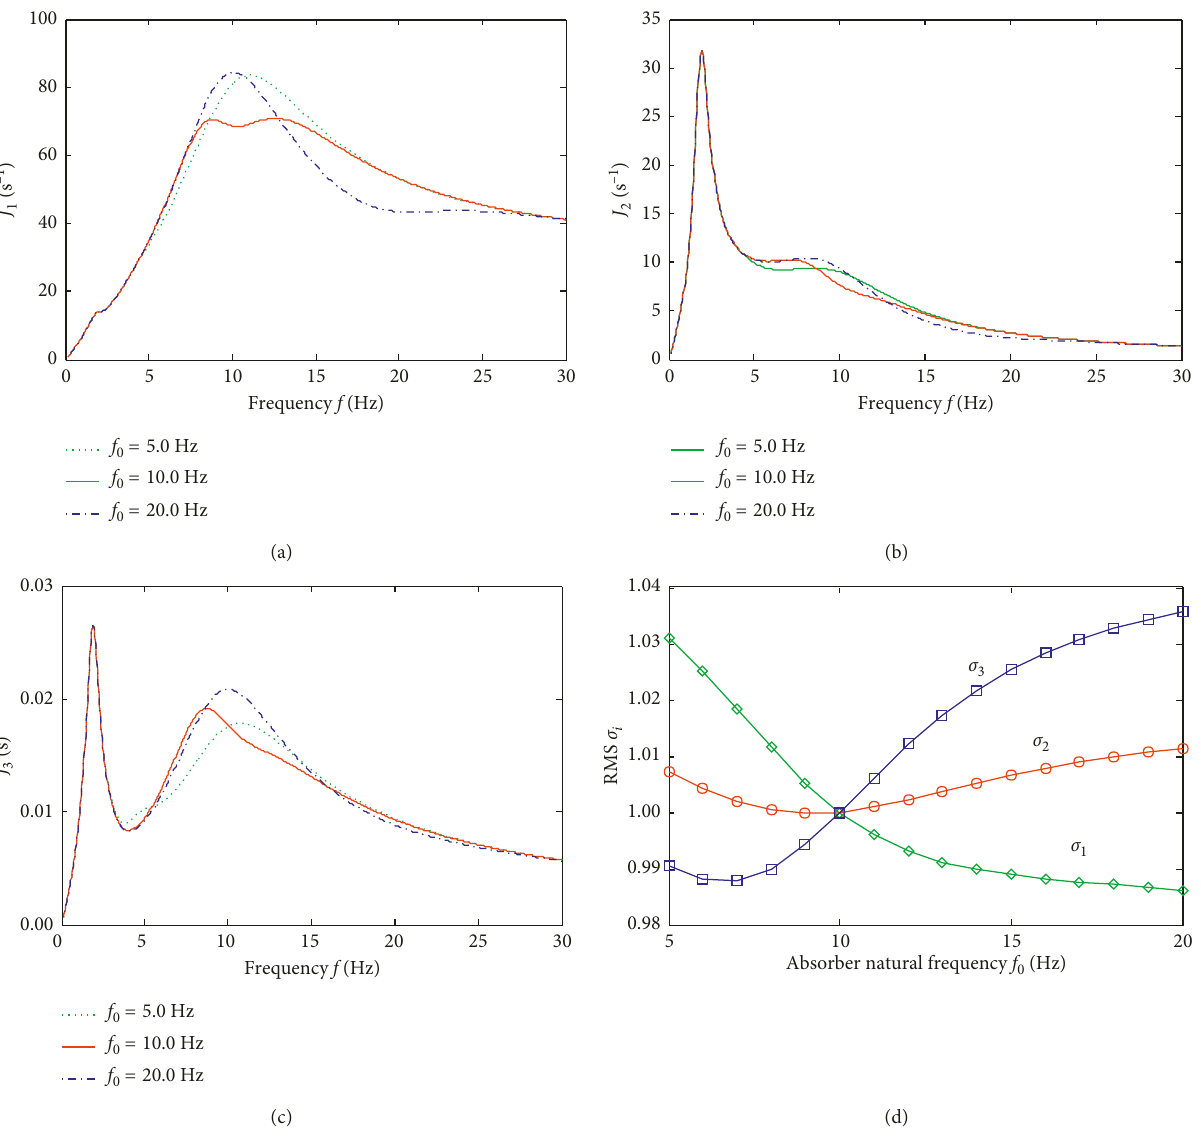
at different values of f 1 at different values of f 3